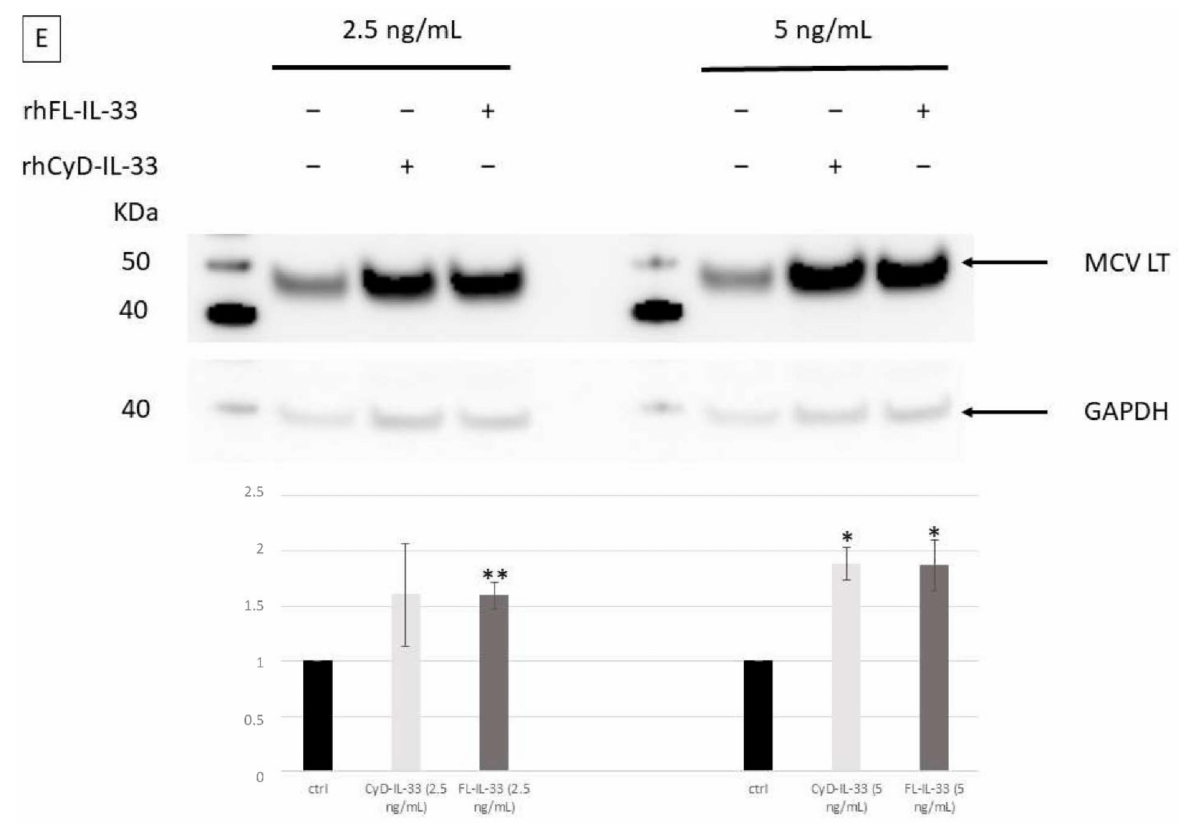
Figure 6. The effect of IL-33 on MCPyV promoter activity in MCC-13 cells. ( A ) Cells were tran- siently co-transfected with either IL-33 expression plasmid or empty expression vector pcDNA3.1, and luciferase reporter plasmid containing either the MCPyV early or the late promoter. Lu- ciferase activity was measured 24 h after transfection. ( B ) MCC-13 cells were seeded and serum starved for 24 h. Cells were then transfected with luciferase reporter plasmid containing either the MCPyV early or the late promoter, and were exposed to FL-rhIL-33 (1.25–5.0 ng/mL), CyD-rhIL-33 (1.25–5.0 ng/mL), or vehicle (PBS) for 4 h before they were harvested and luciferase activity was measured. ( C ) Schematic presentation of the plasmids expressing the full-length or truncated forms of the IL-33 protein. Human IL-33 mRNA (2.7 kb) encodes a protein of 270 residues with three func- tional domains: a nuclear, a central activation domain, and an IL-1-like cytokine domain. Sequences of the different IL-33 domains were cloned into pCMV_His(N)_FLAG(C) plasmid. ( D ) MCC-13 cells were transiently co-transfected with either MCPyV early and late promoter and 250 ng or 500 ng of plasmids expressing different domains of IL-33, IL-33 1–270aa , IL-33 1–65aa , IL-33 1–65 , 112–270aa , IL-33 1–111aa , IL-33 66–111aa , IL-33 66–270aa , and IL-33 112–270aa . Abbreviations: FL-IL33 (full length IL-33), CyD-IL-33 (IL-33 with only cytokine domain). Each bar represents the average of three independent parallels + SD. * p ≤ 0.05, ** p ≤ 0.01, *** p ≤ 0.001, and **** p ≤ 0.0001. ( E ) MCPyV − positive WaGa cells were treated with recombinant full-length IL-33 (rhFL-IL-33) or with the cytokine domains, and expression levels of LT were compared with untreated cells. Levels of GAPDH were used as loading control. Cells were exposed for 16 h with the indicated concentrations of rhFL-IL-33 or rhCyD-Il-33. The experiment was performed two times and a representative result is shown. The ratio for empty vector:GAPDH from the two experiments was arbitrarily set as 1.0 ± standard deviation (* p < 0.05; ** p <